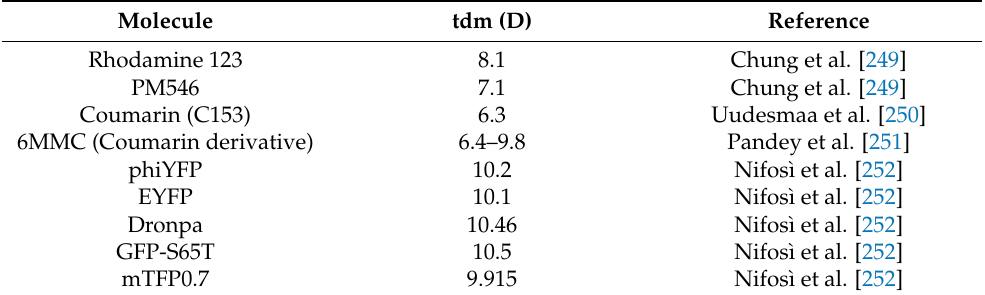
Table 2. Comparison of the transition dipole moment of the molecular fluorophores (rhodamine, pyrromethene and coumarines) with those of some of the reported fluorescent